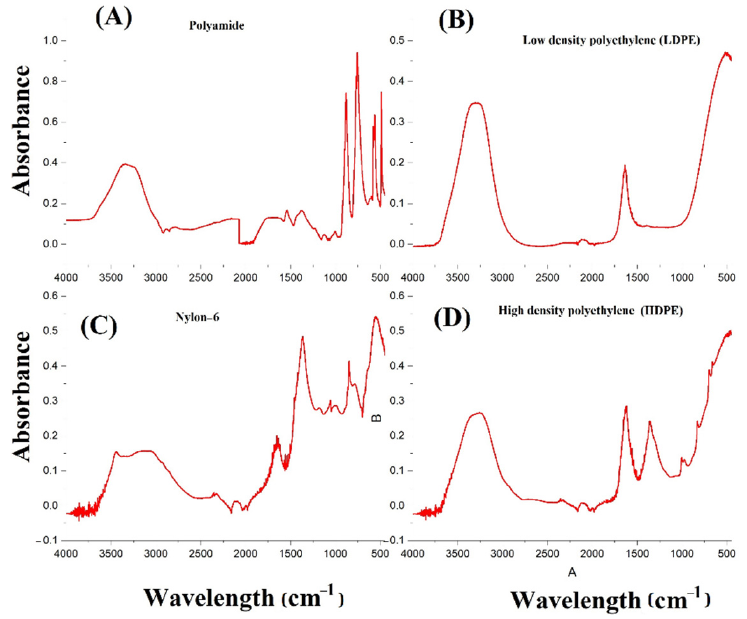
Figure 4. FTIR spectra of polyamide ( A ), LDPE ( B ), nylon 6 ( C ), and HDPE ( D ) present in samples.